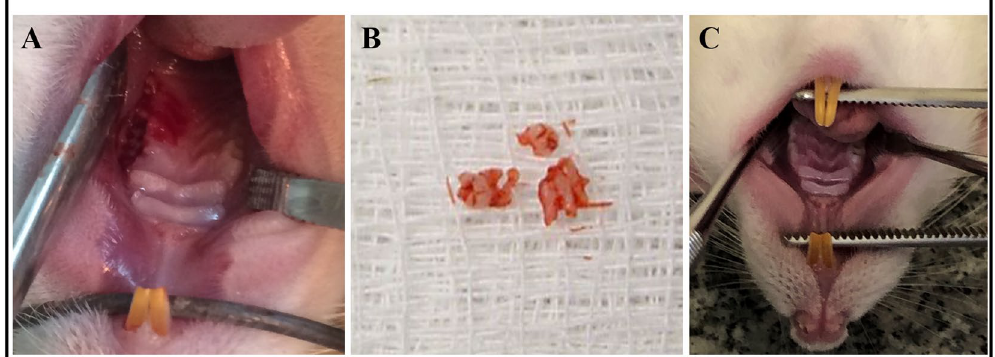
Figure 1. Representative images from rats immediately after the unilateral exodontia ( A ); extracted molar teeth ( B ) and alveolus of rats 14 days after unilateral extraction ( C